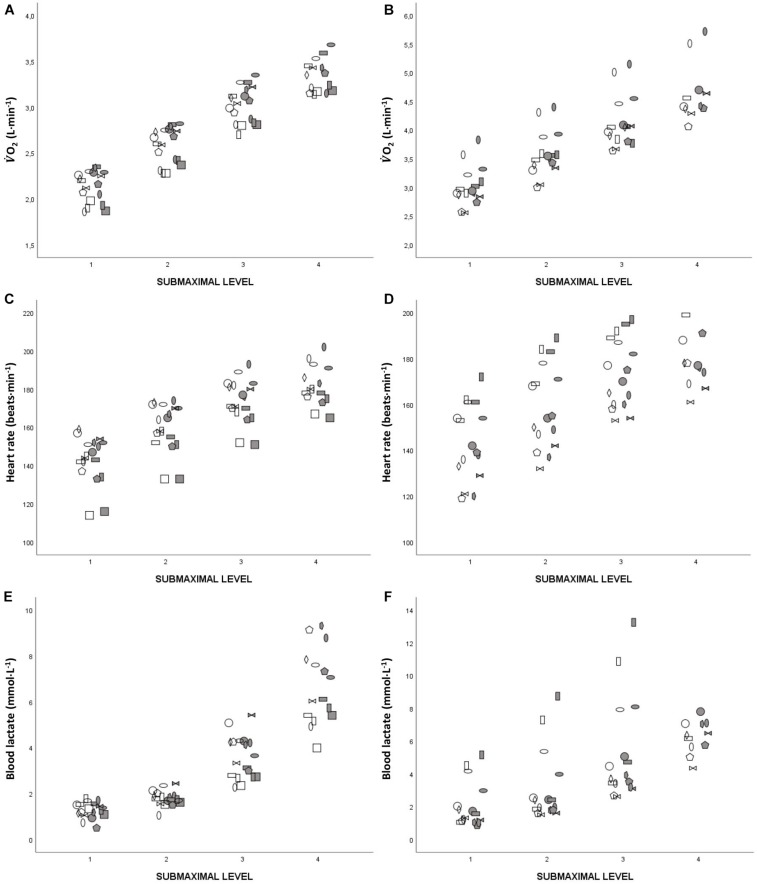
(A–F) Individual responses during the first four submaximal levels for V.O2 (A, females; B, males), heart rate (C, females; D, males), and blood lactate (E, females; F, males). Filled markers represent skiing with the rifle (WR) and unfilled markers represent skiing without the rifle (NR).